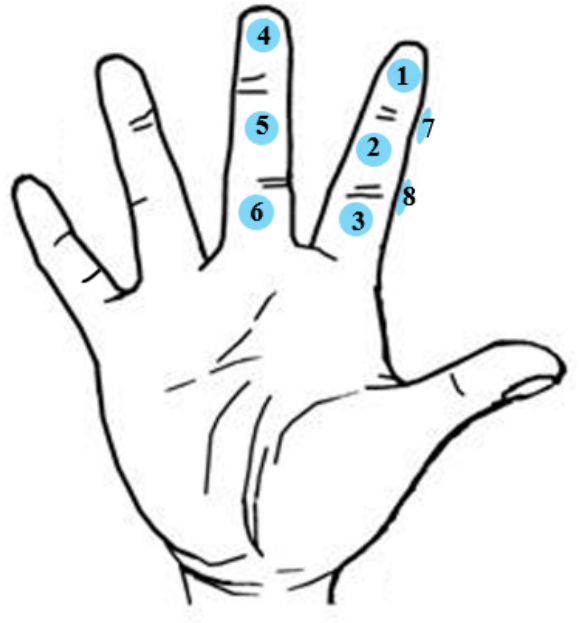
Figure 3. The pressure sensor deployment of